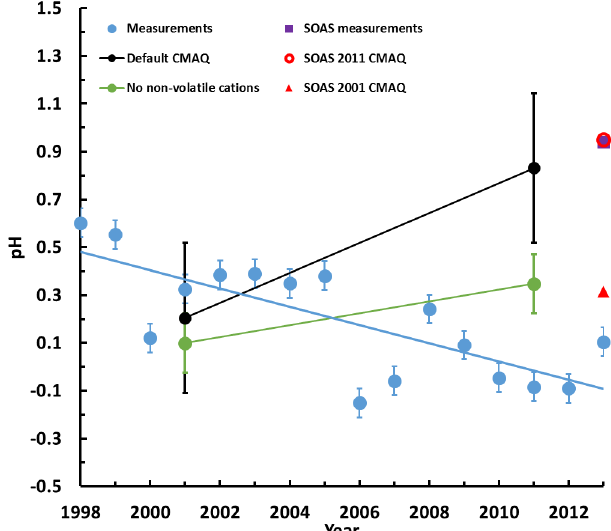
Figure 3. Decadal pH trends from the thermodynamic analysis of the measurements from Weber et al. (2016) (blue line), default CMAQ (black line) and CMAQ results at the Centreville grid cell without crustal elements (green line). Also shown is the pH for the SOAS campaign and the CMAQ-predicted pH for 1 June–15 July 2001 and 2011. CMAQ exhibits a clear positive trend, with pH in- creasing throughout the decade, both due to sulfate reductions and the increasingly important role of NVCs. Standard error is also plot- ted for all data points.